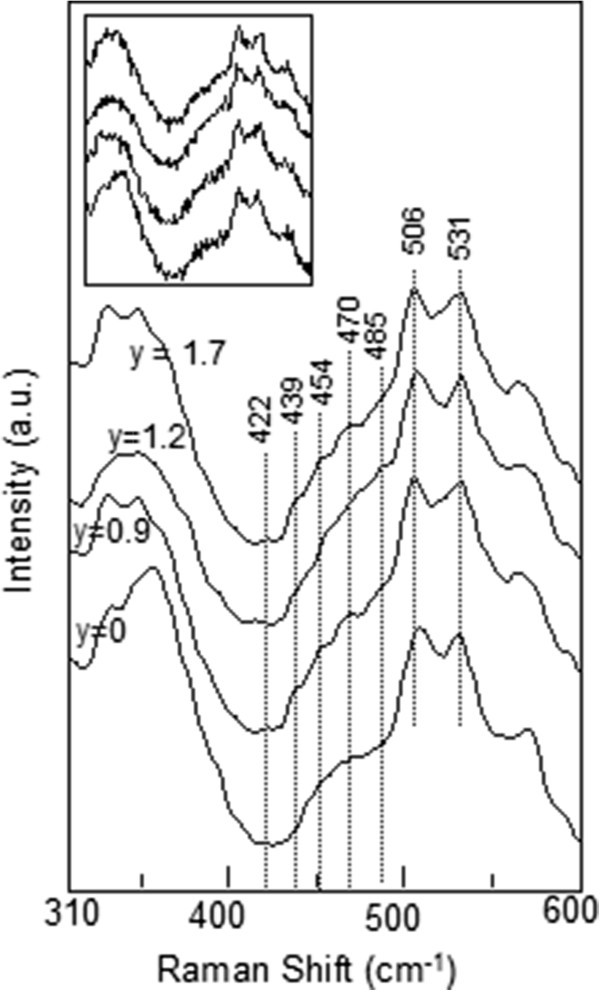
Micro-Raman spectra with 532-nm laser of n-type Ga0.68In0.32NyAs1 − y/GaAs QW samples with different N concentrations. The inset shows the unsmoothed raw Raman spectra of the samples